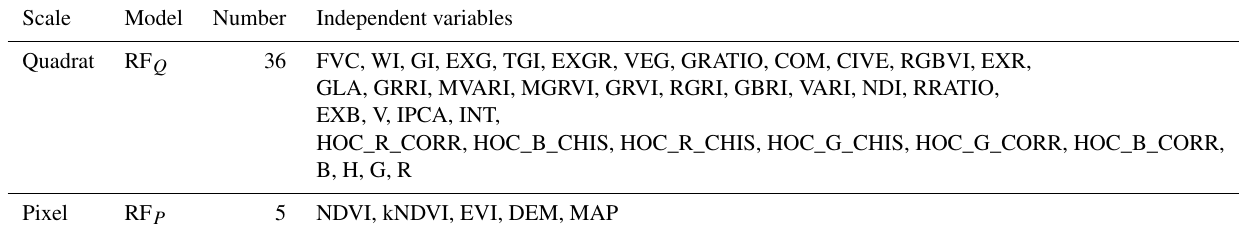
Table 2. Selected independent variables for the AGB modeling at quadrat and pixel scales. The full names of each variable at the quadrat scale are listed in Table A3.